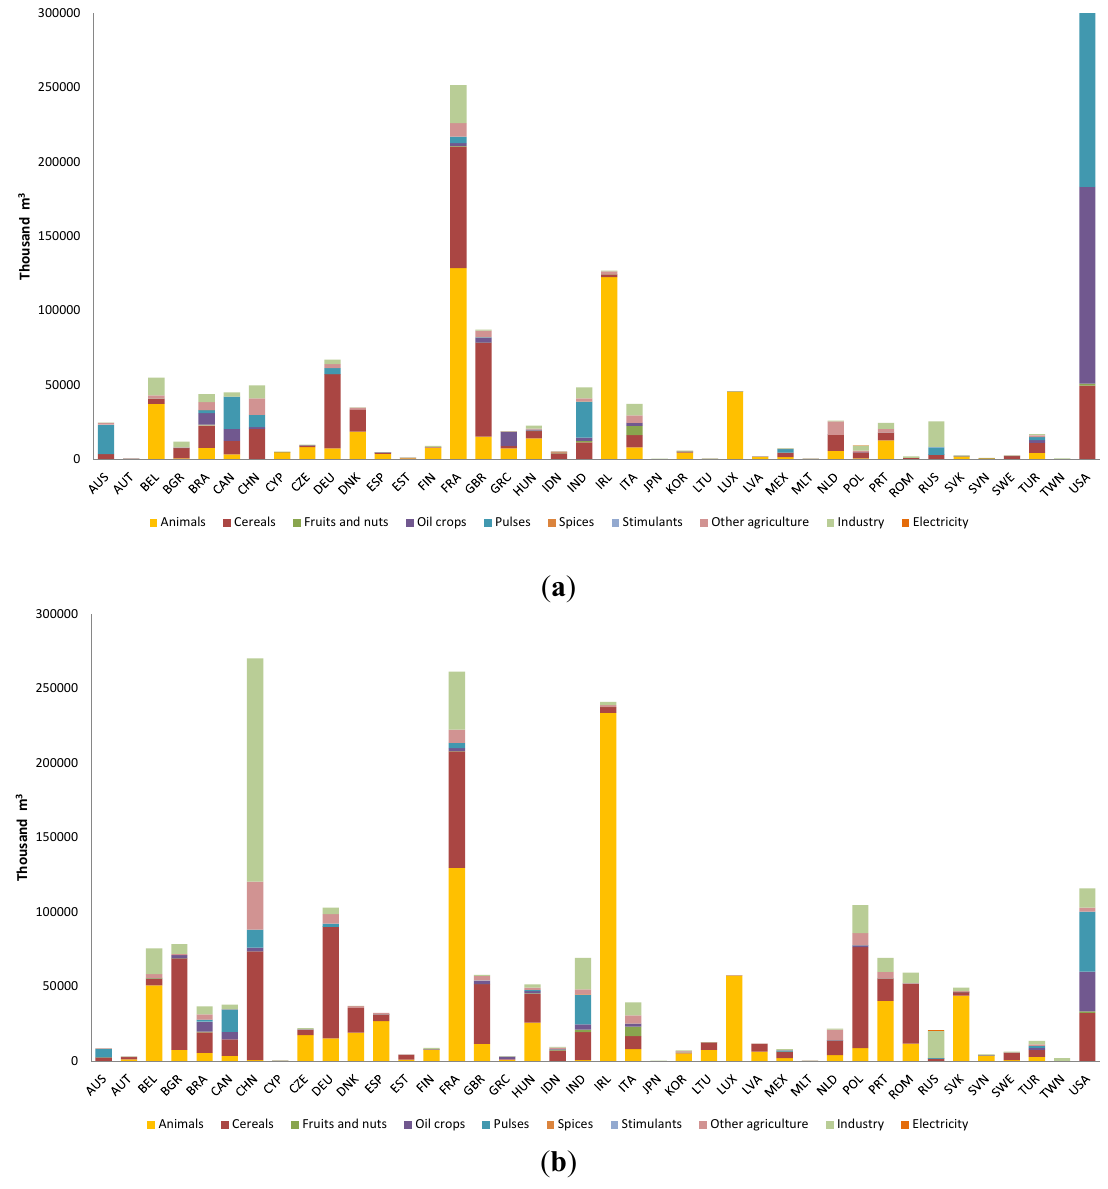
Figure 4. Grey virtual water imports of the food sector by country and sector in 1995 ( a ) and 2009 ( b ), thousand m 3